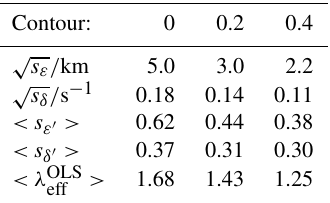
Table 1. The average value of the (square root of) error variances in height and log 10 ( 1 /τ) ; s ε (cid:48) and s δ (cid:48) are given along with the average value of λ from SCT calibration ( λ OLS ) at contour levels 0, 0.2 and eff 0.4 for winter